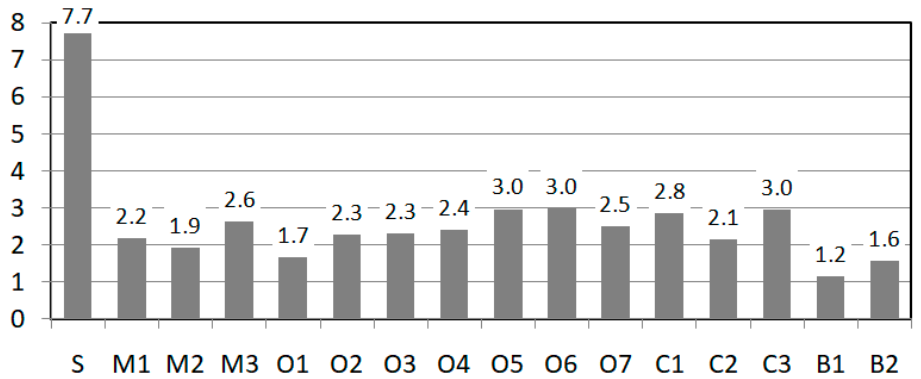
Figure 2. Average values of all answers. “S” denotes overall satisfaction (max 10), “B1”—“my” behavior, “B2”—“our” behavior, other variables are defined in Table 2, and they range from 1 (best) to 5 (worst).